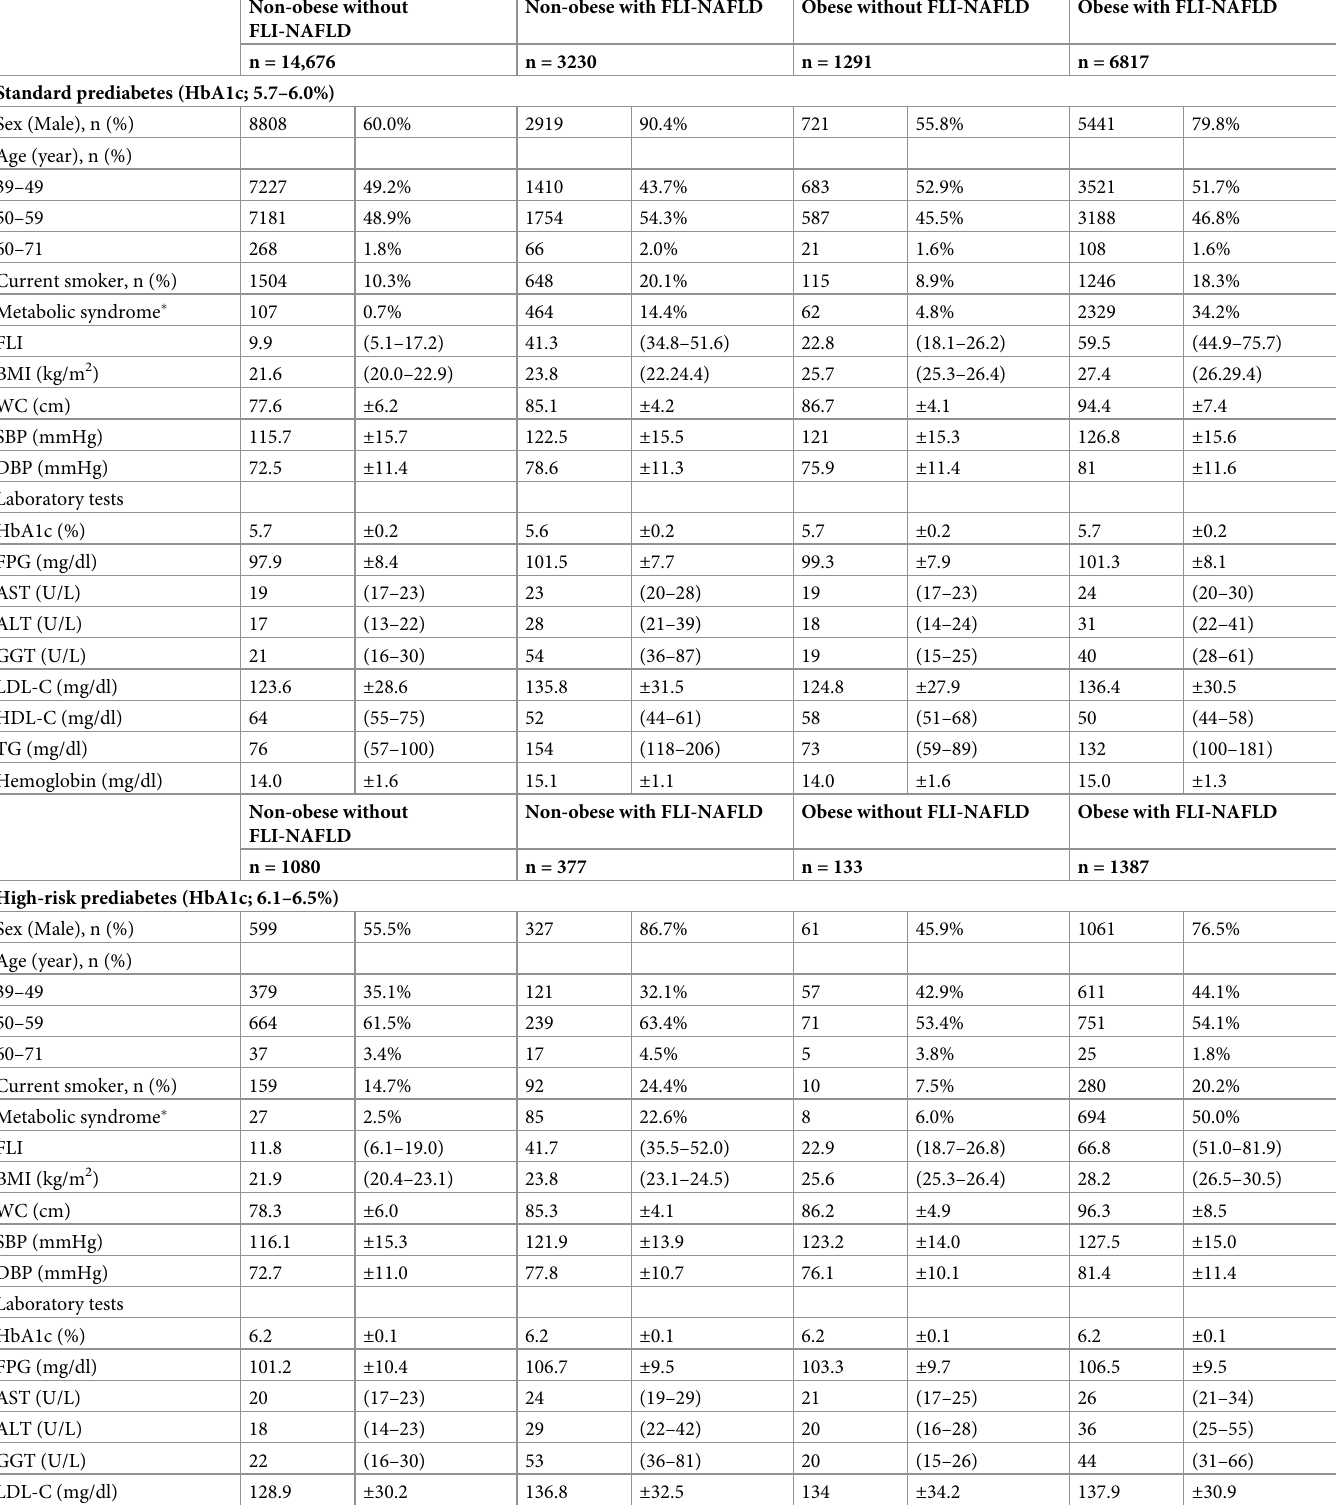
Table 1. Baseline characteristics of eligible